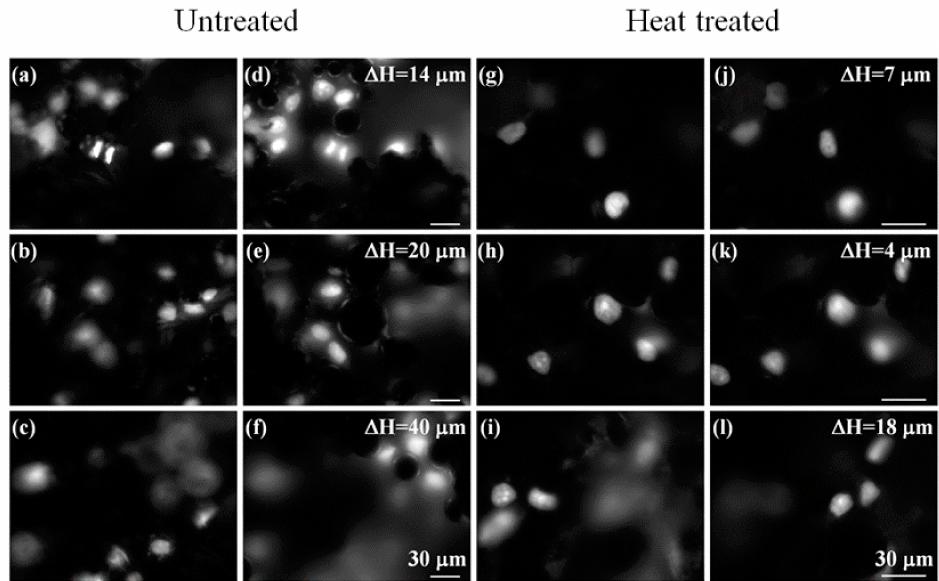
Figure 8. Fluorescence images of MG-63 cells attached to Ti64 specimens (cell nuclei stained with PI). ( a – c )/( d – f ) and ( g – i )/( j – l ) are the highest/lowest positions of MG-63 cells attached to untreated and heat-treated Ti64 specimens, respectively. Scale bar 30 µ